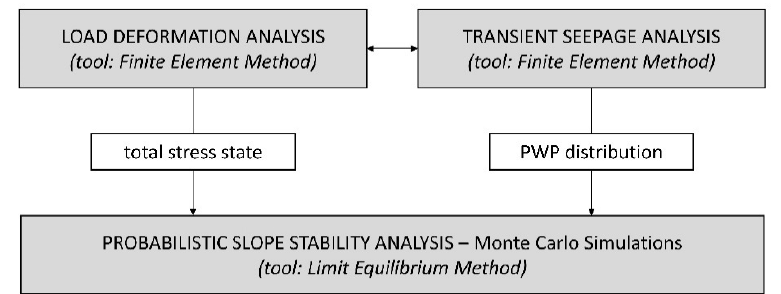
Figure 2. Workflow of probabilistic analysis of levee slope stability.